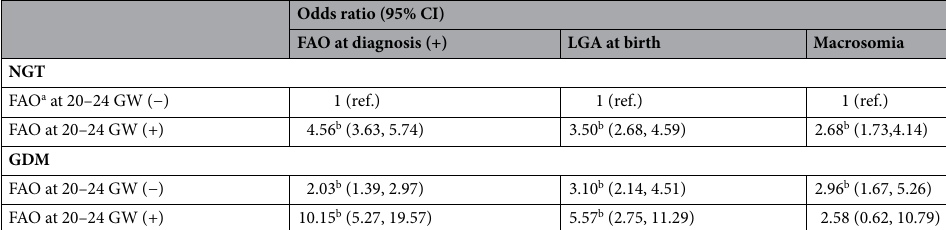
Odds ratio (95% CI) FAO at diagnosis (+) LGA at birth Macrosomia FAO a at 20–24 GW (−) 1 (ref.) 1